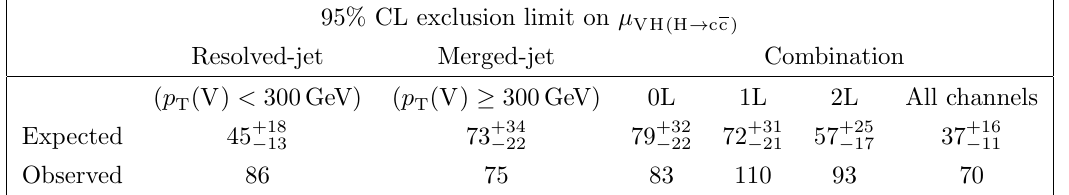
for the VH(H ! cc) process, VH(H ! cc) (V) < 300 GeV, the merged-jet topology analysis for T